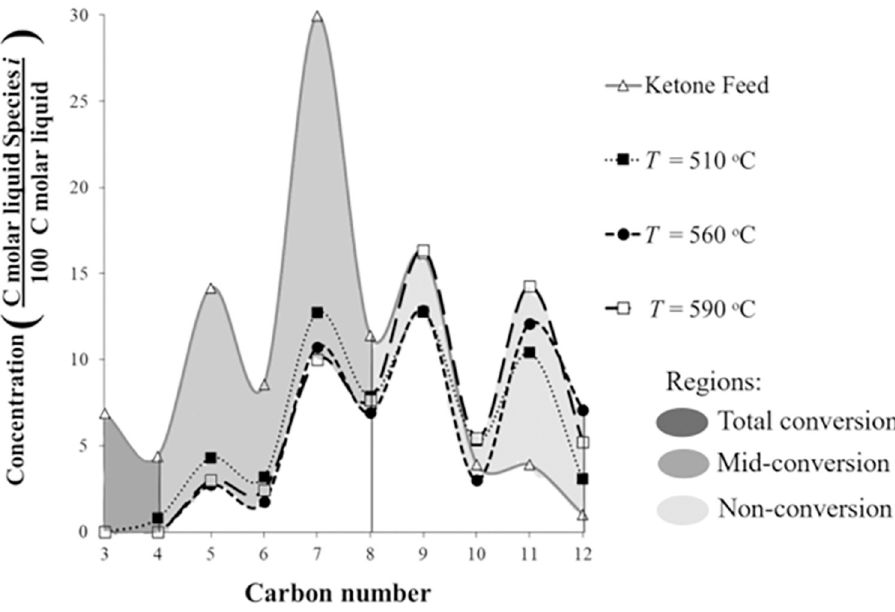
Fig 15. Liquid unreacted product ketone distribution of mixed-ketone reaction over HZSM-5(280), WHSV = 1.9 h –1 , and P = 101 kPa (abs).